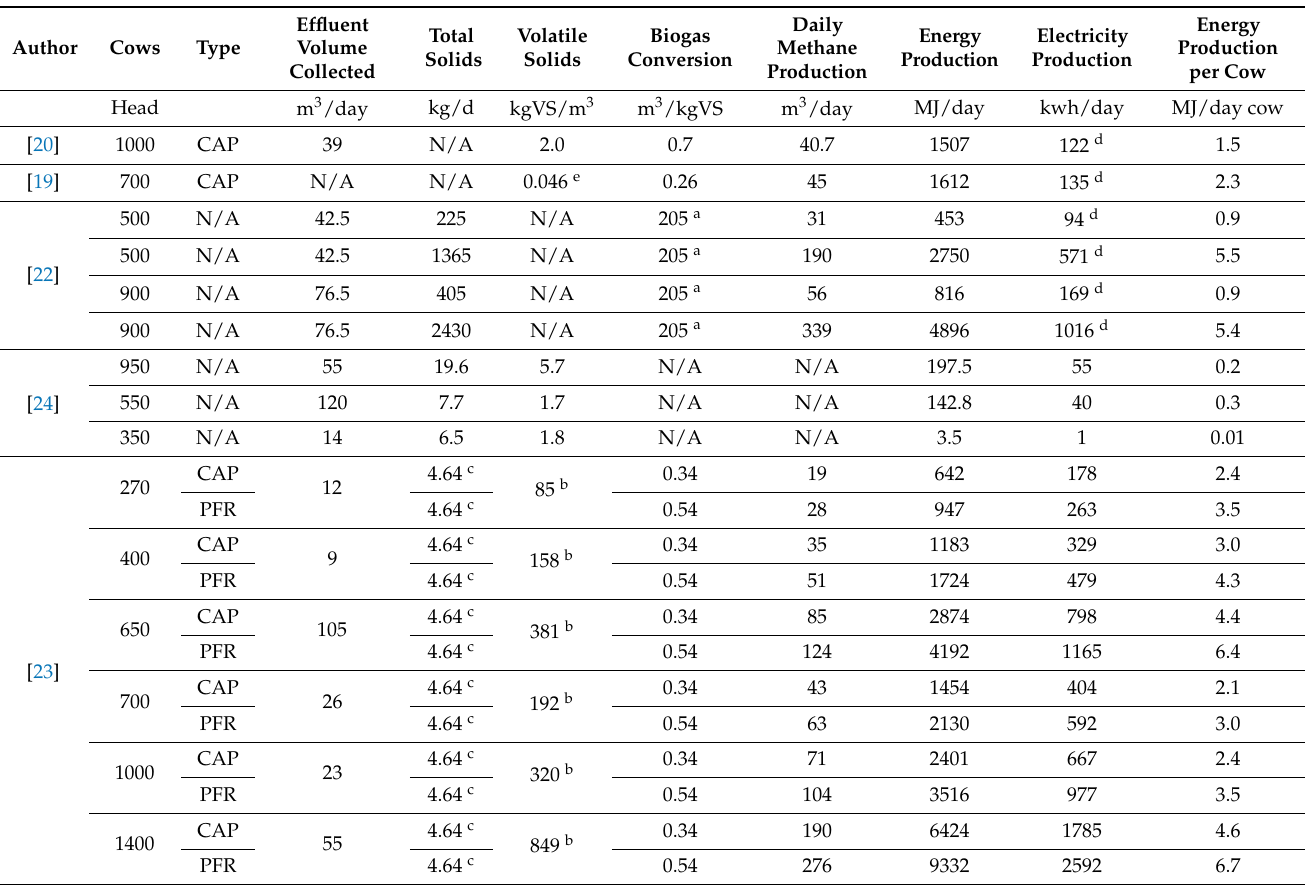
Table 3. Summary of findings of anaerobic digestion in New Zealand